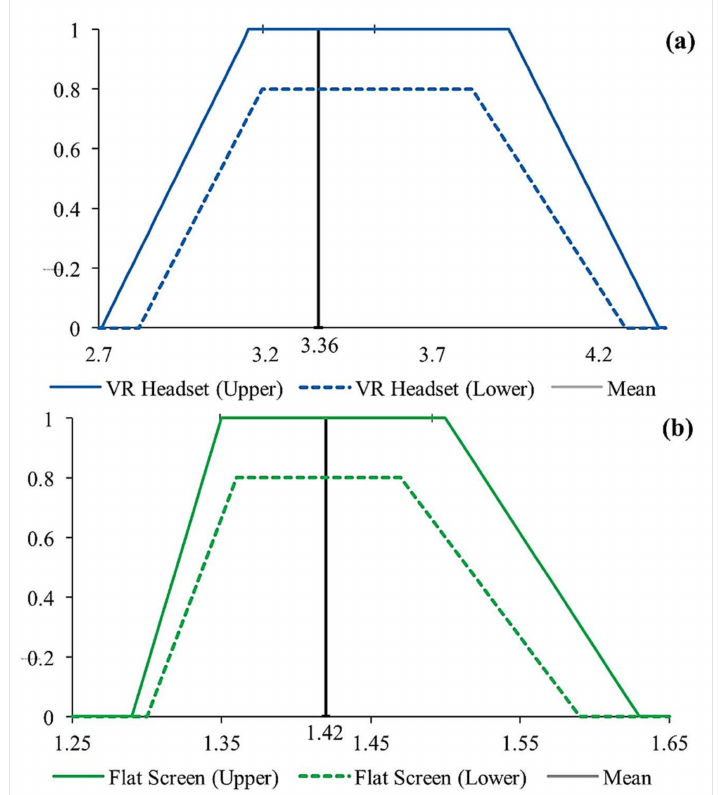
Figure 11. Global weights of alternatives for subfactors.